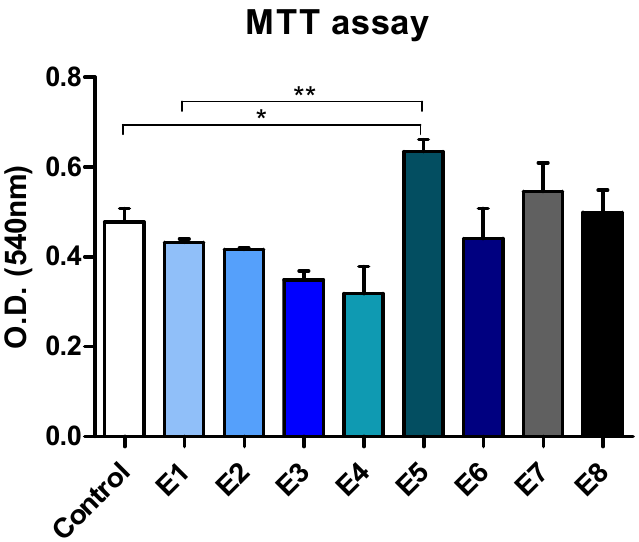
Figure 14. L929 cell viability and proliferation measured by the MTT test. O.D., optical density (statistical significance: * p < 0.05, ** p < 0.01). The control is represented by unstimulated cells in standard culture conditions.